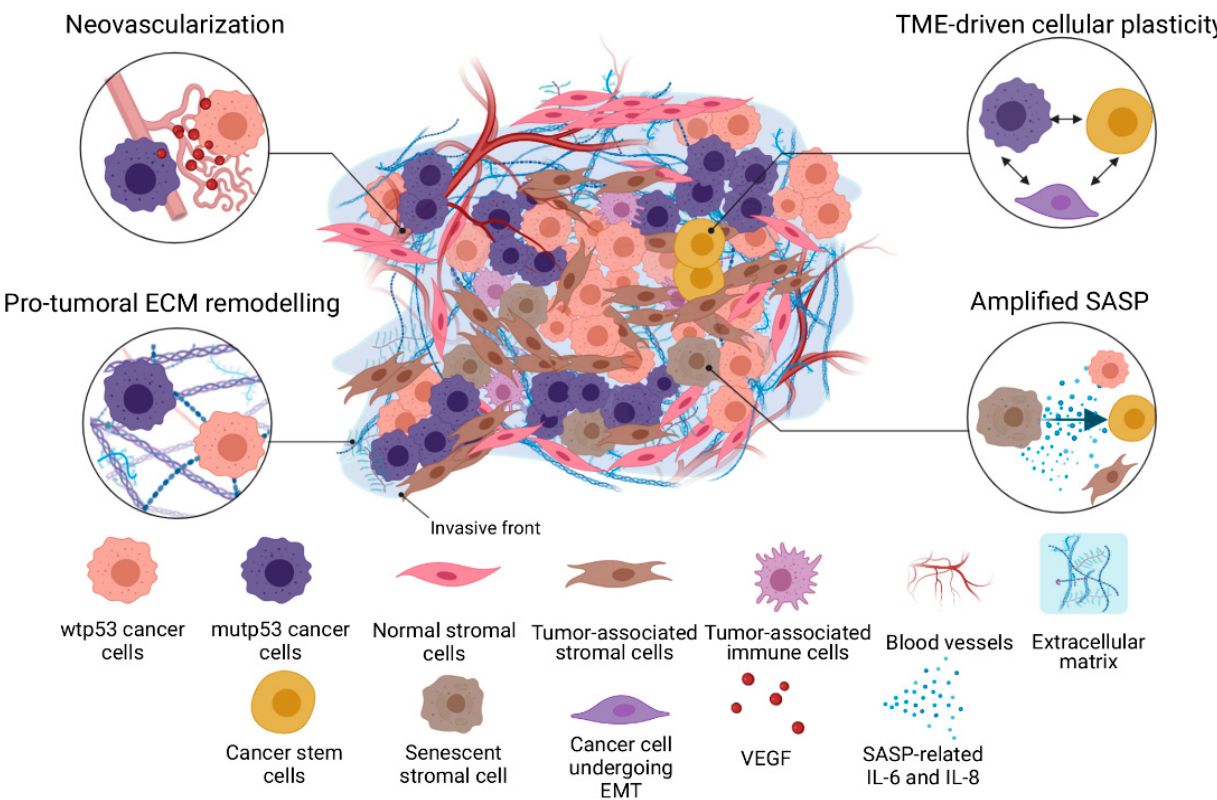
Figure 1. Mechanisms of TME-driven chemoresistance promoted by p53 loss. Tumor